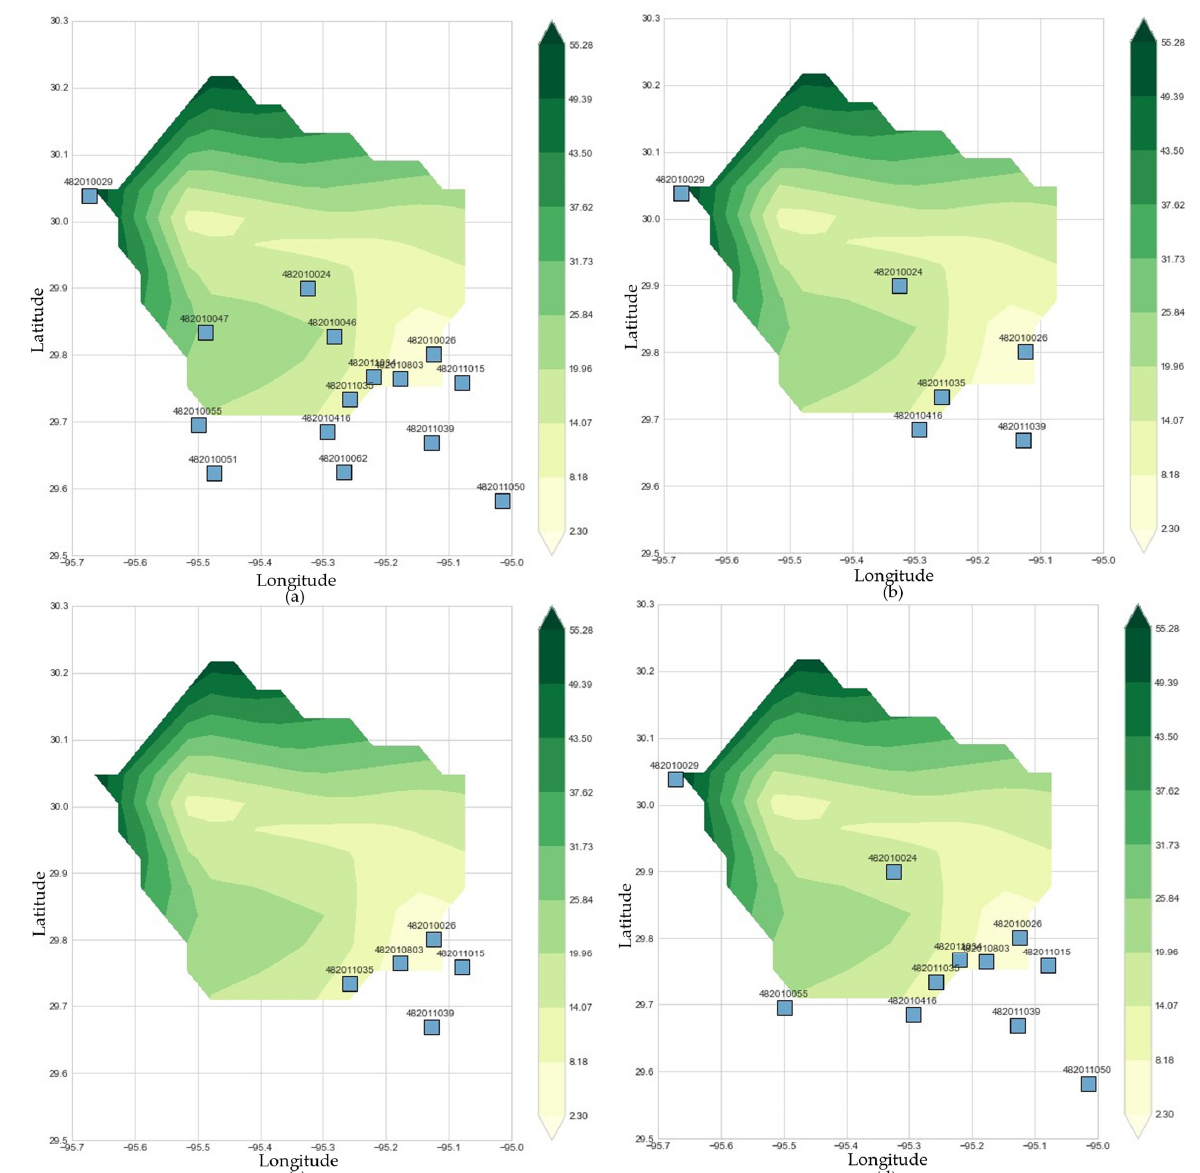
Figure 2. Topographic maps showing the spatial distribution for the used stations for